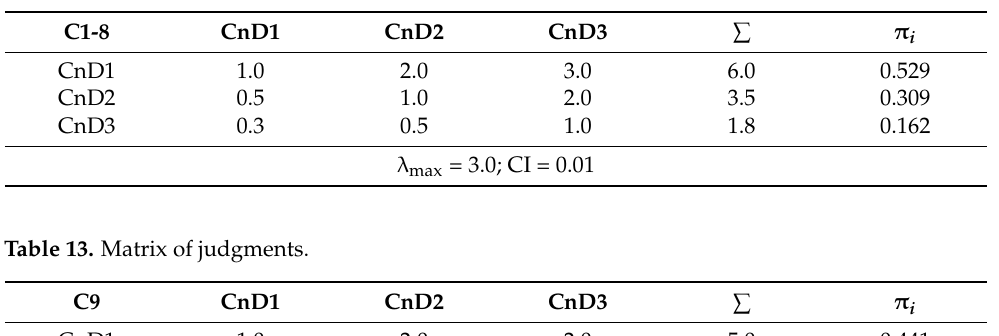
Table 12. Matrix of judgments.